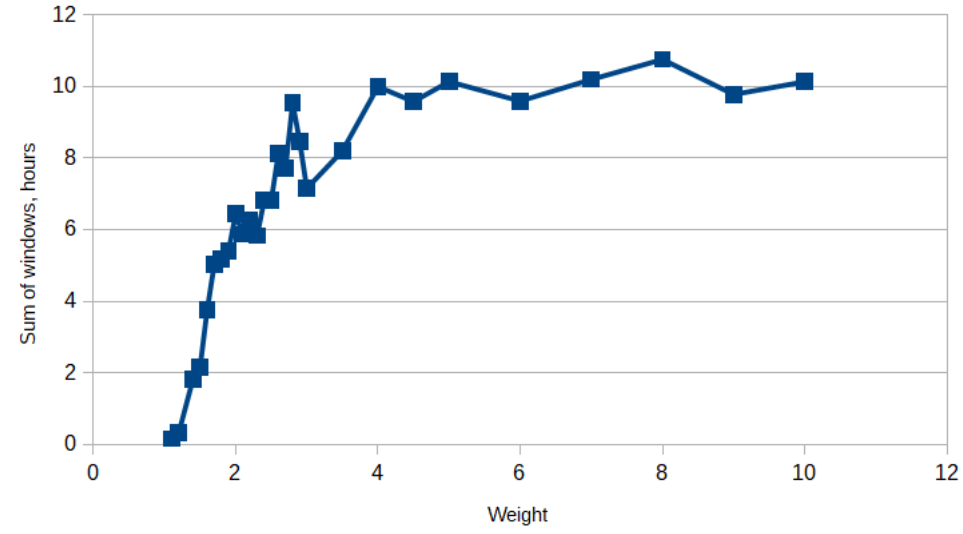
Figure 2. More detailed dependency diagram of the total duration of all schedule gaps on the weight w 0 , 1 ≤ w o ≤